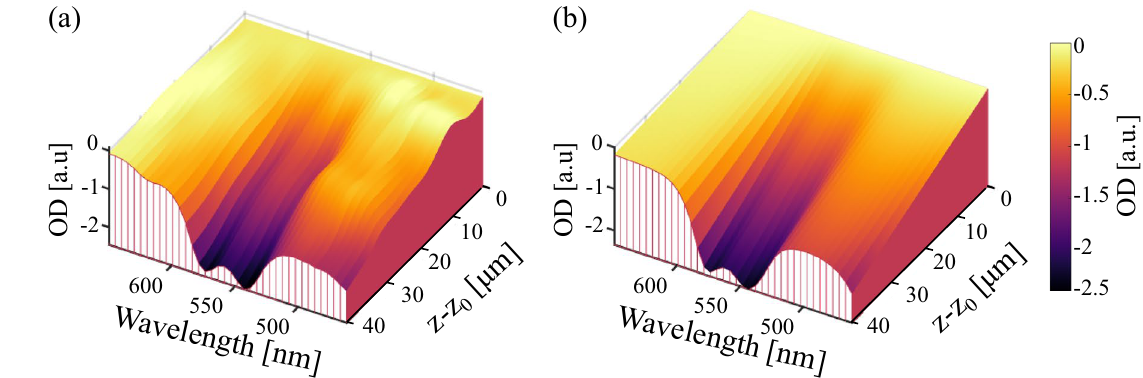
Figure 3. Comparison between the ODs obtained with conventional sOCT for an expected [tHb] = 16.9 g/dL with a coefficient of determination R 2 = 0.97 . (a) Experimental OD and (b) estimated reached convergence.